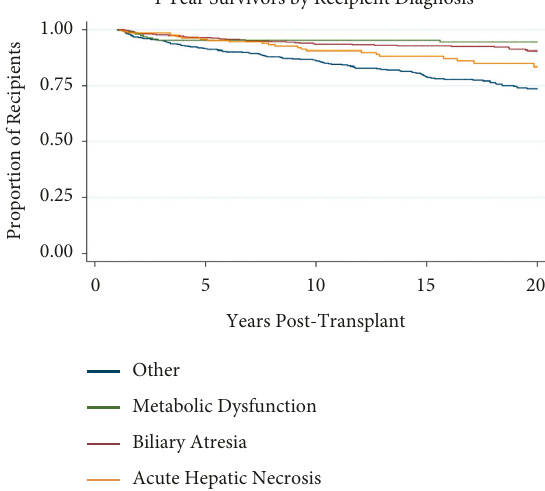
Figure 4: Kaplan–Meier survival function over time for 1-year survivor pediatric liver transplant recipients by primary recipient diagnosis.